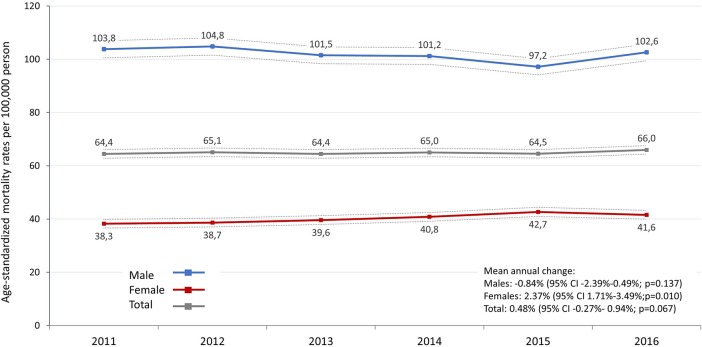
Age-standardized mortality rates (standard: ESP 2013) of lung cancer by sex in Hungary between 2011 and 2016 (per 100,000 person-years; dotted lines represent the 95% CI). CI, confidence interval.